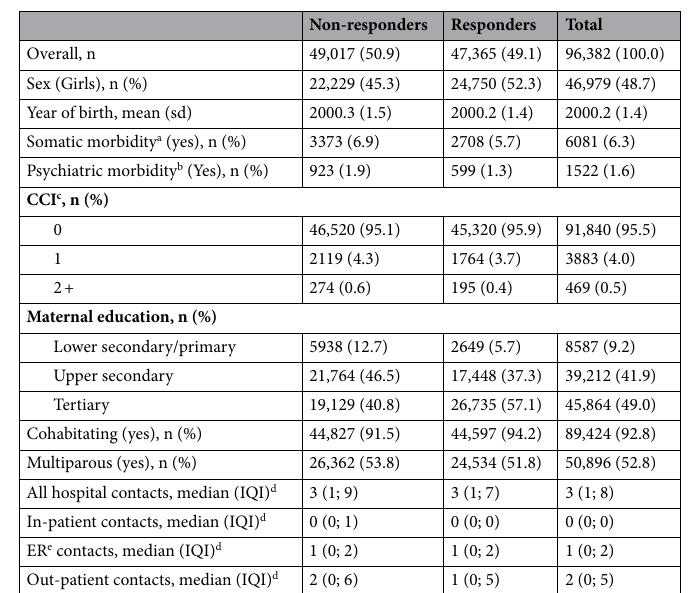
Table 1. Characteristics of responders and non-responders at the 11-year follow-up of the Danish National Birth Cohort. a As defined in methods section. b Any ICD-10 DF-diagnosis. c Charlson Comorbidity Index. d From index date to end of follow-up. IQI reflects the 25–75-percentile interquartile interval. To comply with Danish data-protection legislation, we report pseudo-medians and pseudo-interquartile intervals, calculated by ordering all observations and averaging the 5 values closest to the relevant percentile. e Emergency